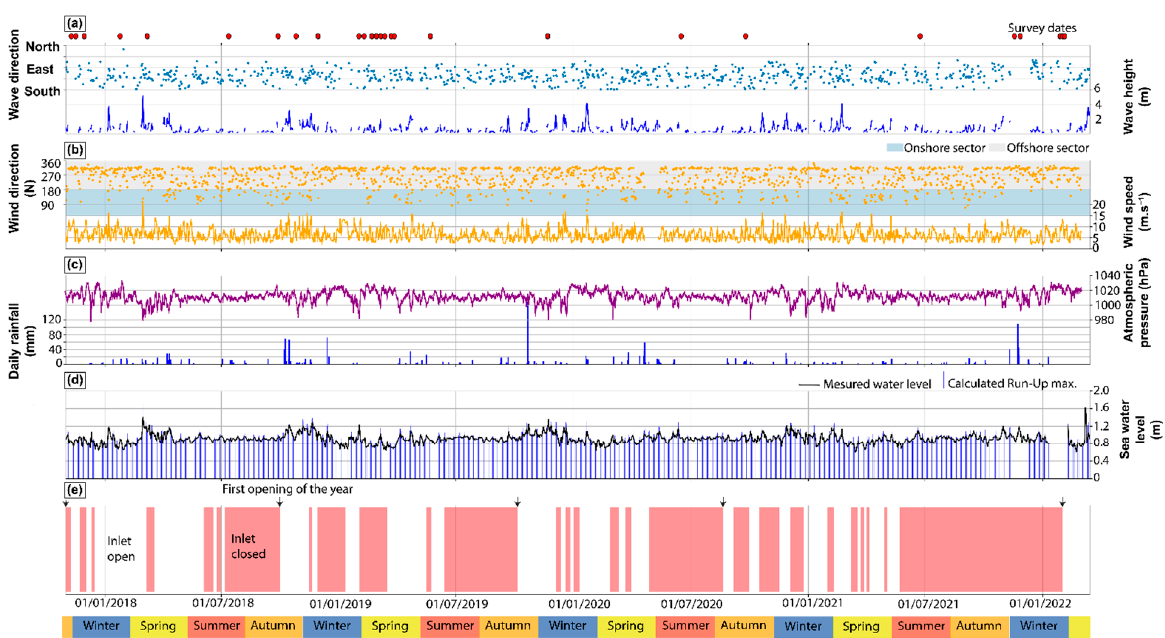
Figure 2. Recorded daily forcing conditions during the monitoring period. ( a ) Wave direction and height (periods of offshore-directed waves are not indicated for sake of clarity as they are not relevant for beach morphodynamics); The dates of the surveys are indicated by the red circles; ( b ) Wind direction and speed; ( c ) Precipitation and atmospheric pressure; ( d ) Water level and calculated values of run ‐ up; ( e ) State of the inlet (open in white/closed in red).